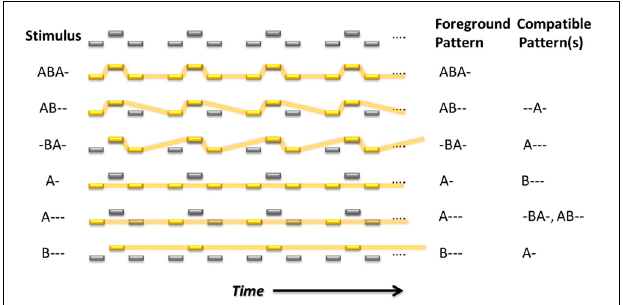
FIGURE 1 | Embedded repeating patterns up to length four that can, in theory, be perceived by listeners in the auditory streaming paradigm. Yellow rectangles indicate the foreground pattern. Feature differences, in this case frequency differences, are indicated by displacement in a vertical direction for the tones in each sequence. The foreground and compatible (background) patterns for each dominant (emphasized) pattern are indicated to the right in letter